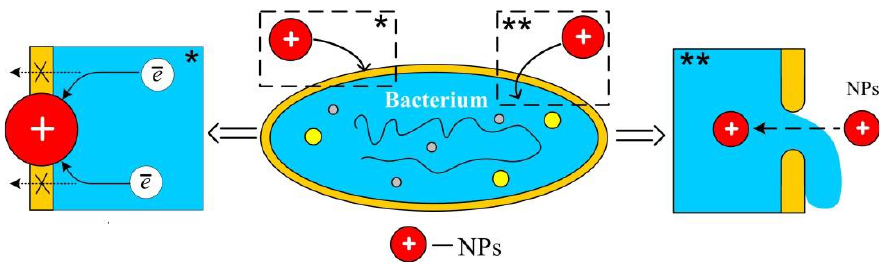
Figure 1. Mechanism of antimicrobial effect of positively charged nanoparticles (using the example of chitosan nanoparticles).